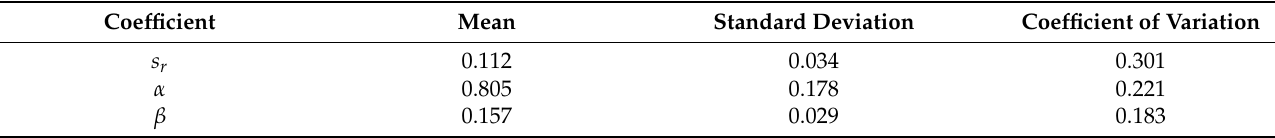
Table 8. Statistical results of fitting